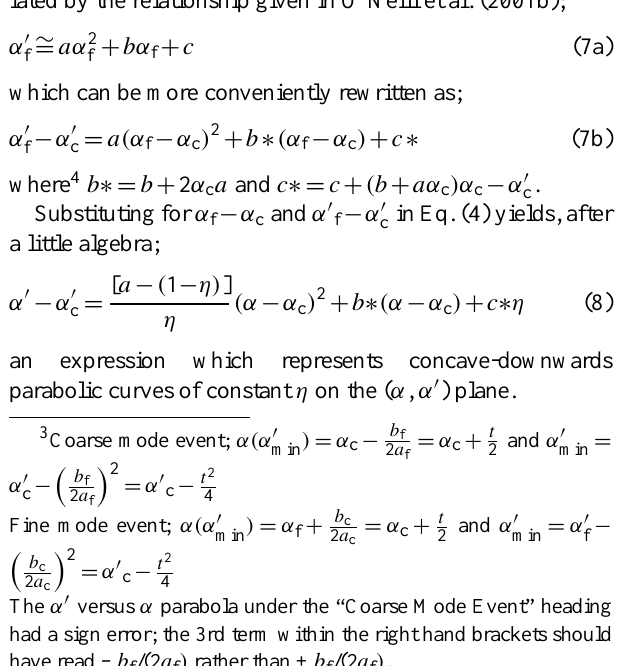
The α 0 versus α parabola under the “Coarse Mode Event” heading had a sign error; the 3rd term within the right hand brackets should have read – b f /(2 a f ) rather than + b f /(2 a f ) . 4